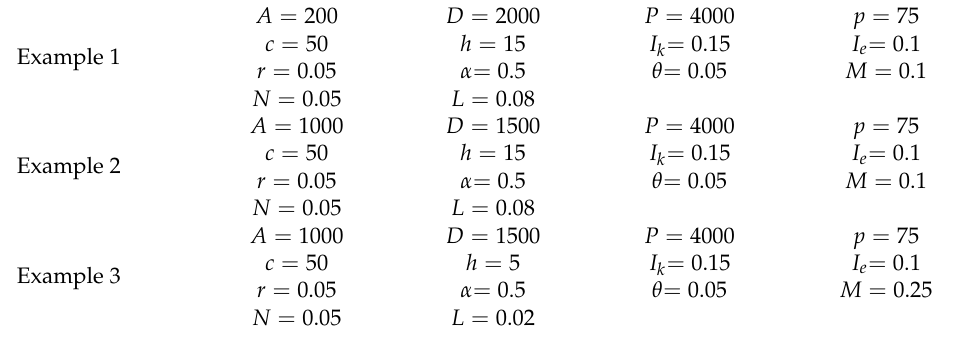
Table 2. Let us consider an inventory system with the following data for Example 1–3.